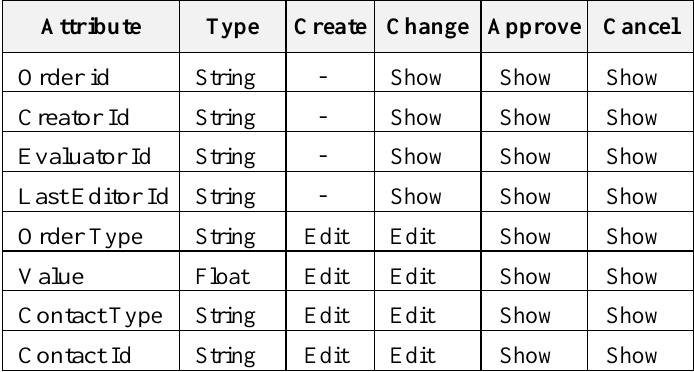
Table 4. Data object and form